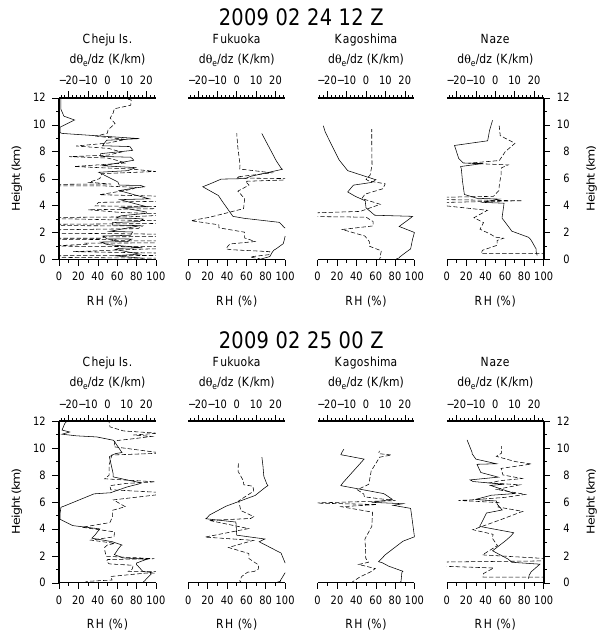
Fig. 7. Vertical profile of the relative humidity (solid line) and verti- cal gradient of the equivalent potential temperature θ e (dotted line) obtained from rawinsonde